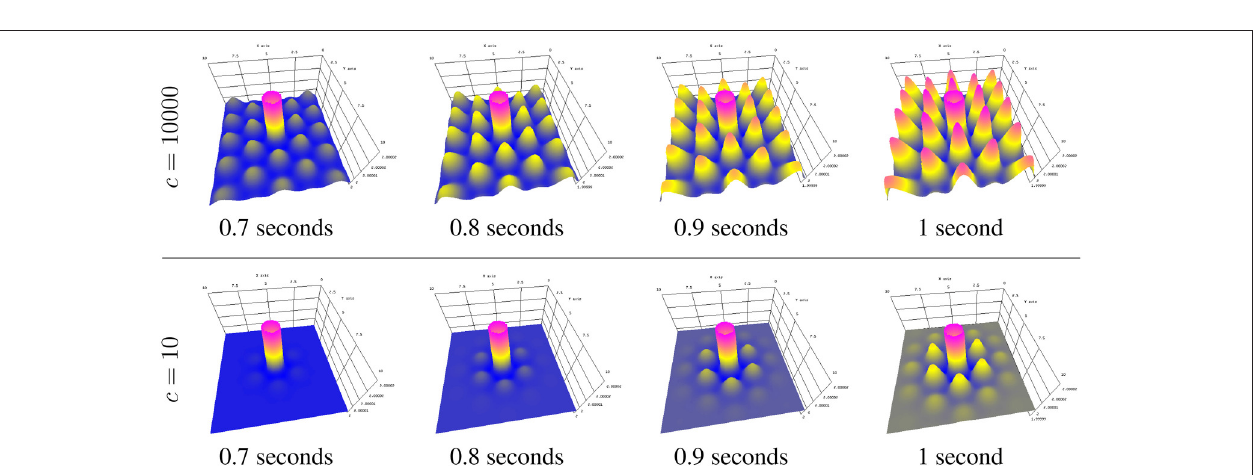
FIGURE 6 | Turing patterns in neural field activity forming over time during the same simulation.